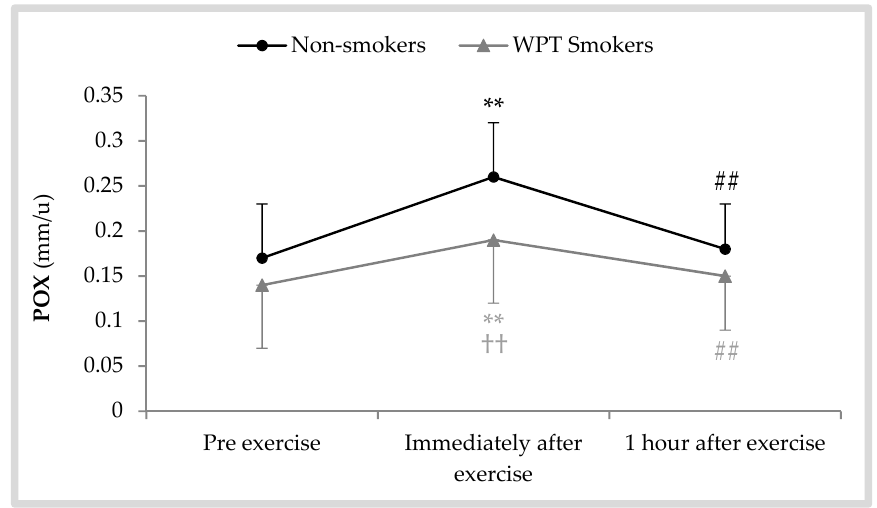
Figure 3. Salivary peroxidase (POX) activity following a bout of exhaustive aerobic exercise in WPT smokers and non-smokers; ** p < 0.01 vs. pre, ## p < 0.01 vs. immediately after, †† p < 0.01 vs. non-smokers.